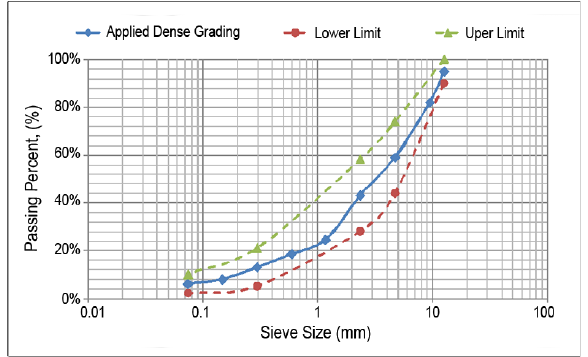
Fig. 2. Grading curve used for granite and limestone